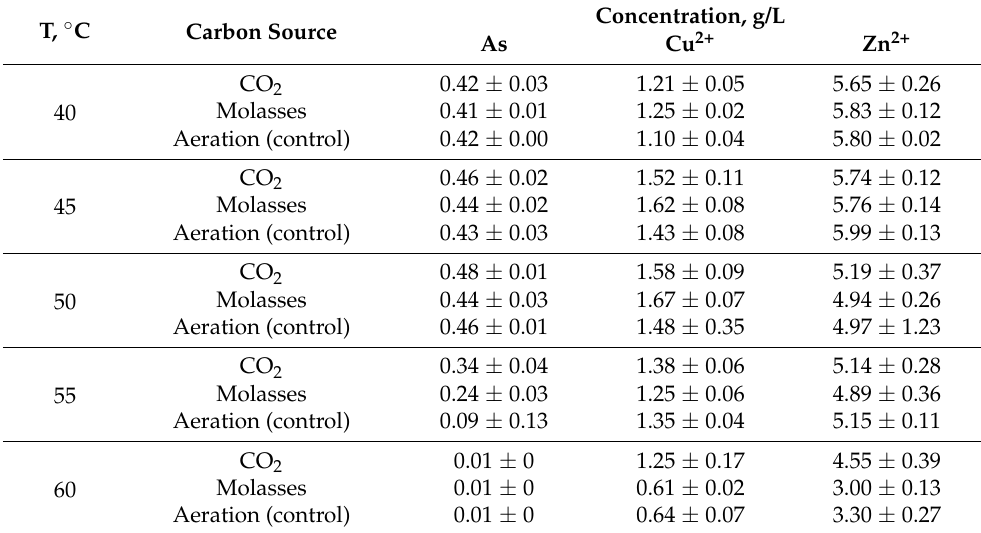
Table 3. Parameters (As, Cu, and Zn concentrations) of the liquid phase of the pulp at the end of the experiment (steady state